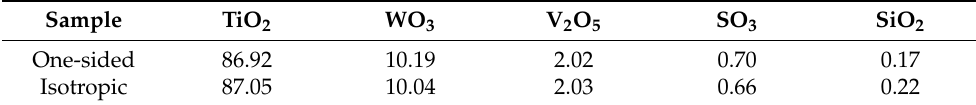
Table 2. X-ray fluorescence analysis of the V 2 O 5 -WO 3 /TiO 2 prepared by the one-sided heating and isotropic heating methods.